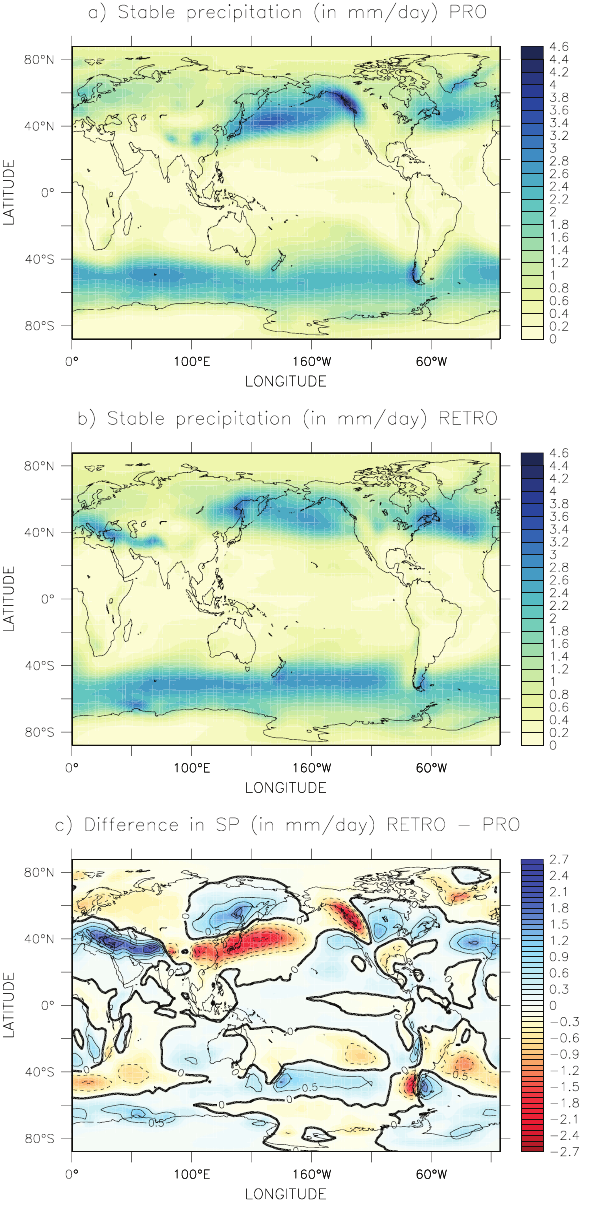
Fig. 6. Stable (non convective) precipitation (SP) in mm/day in (a) PRO; (b) RETRO and (c) the difference field. The North Atlantic in RETRO receives more (stable) precipitation and the North Pacific receives less. Southern Europe and the Middle East are much wetter in RETRO.